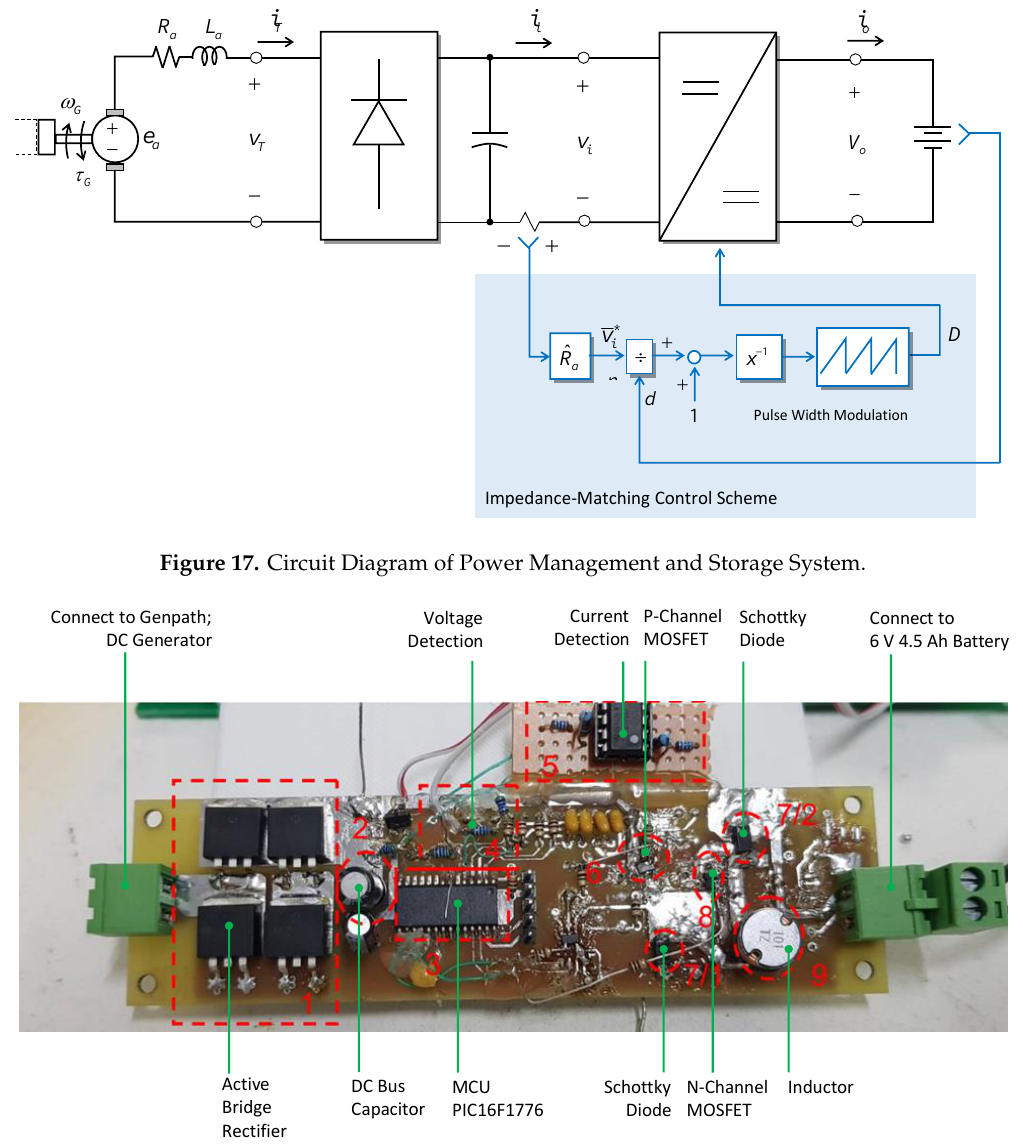
Figure 18. Real-World Circuit of Power Management and Storage System.